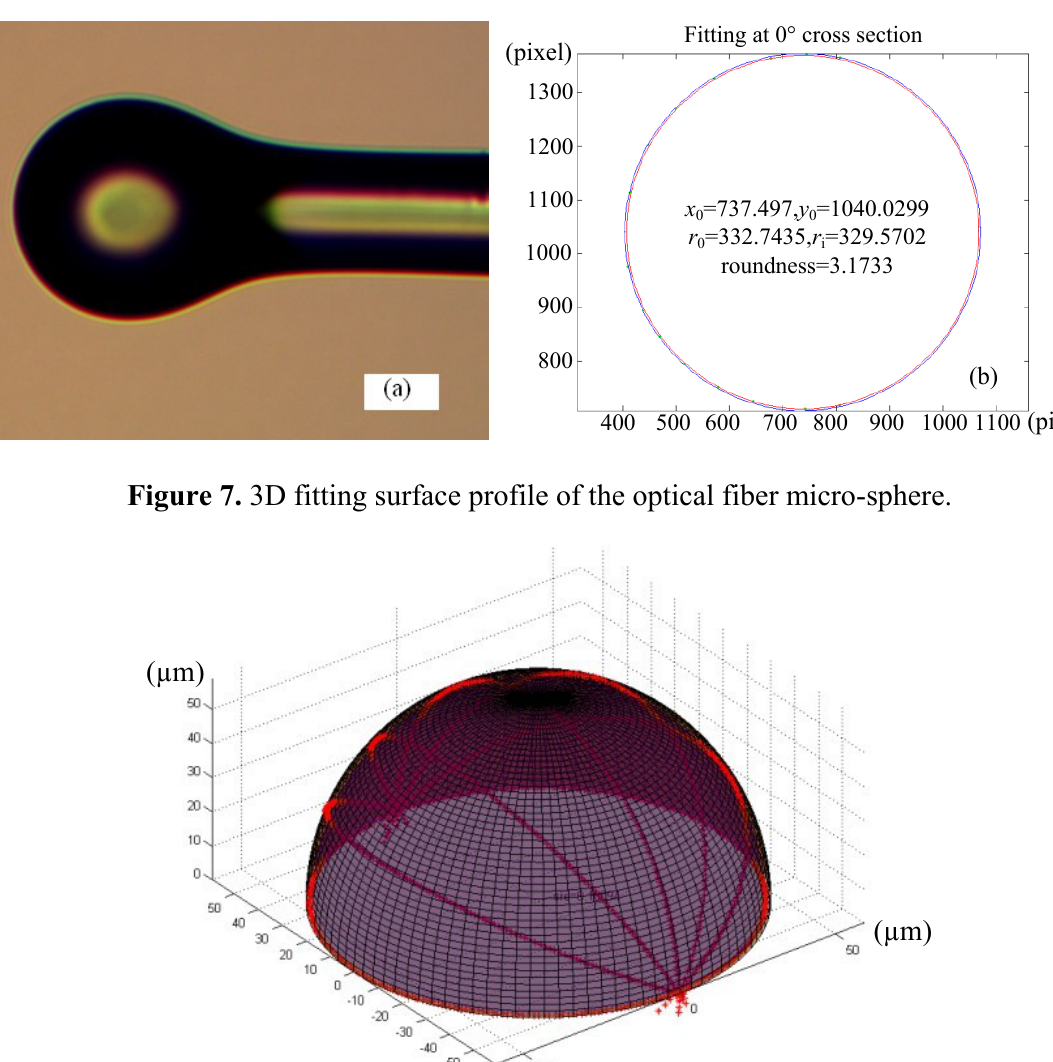
Figure 6. 2D cross section of micro-sphere. ( a ) Photography of 2D cross section; ( b ) 2D fitting image.